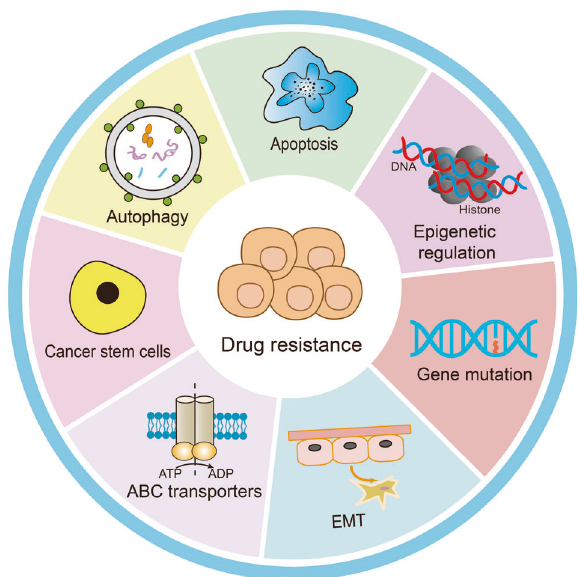
Fig. 1 Common drug resistance mechanisms. There are seven main reasons that can lead to cancer drug resistance, including over- expressed ABC transporters, CSCs, autophagy, apoptosis, gene mutations, EMT, and epigenetic regulation